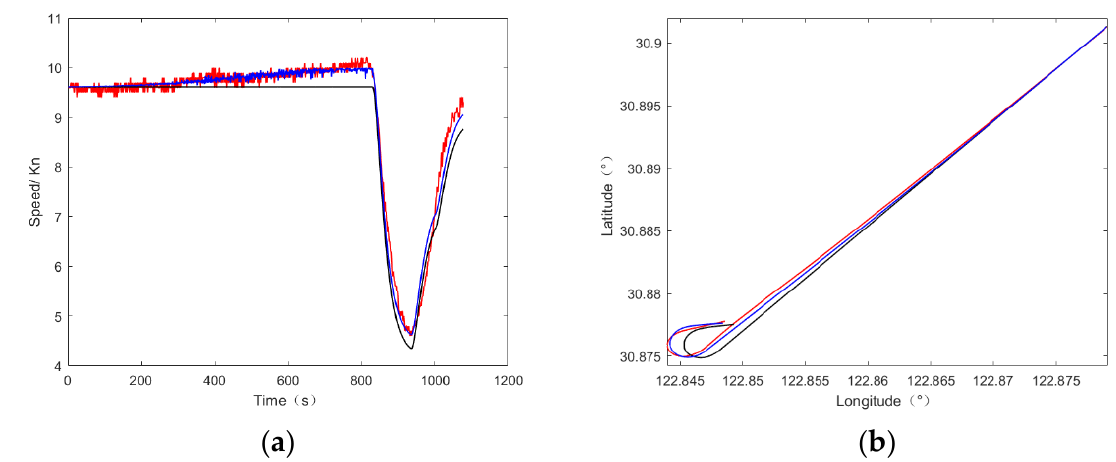
Figure 11. Comparison chart with and without interference and measured data. ( a ) Speed comparison chart ( b ) Track comparison chart.